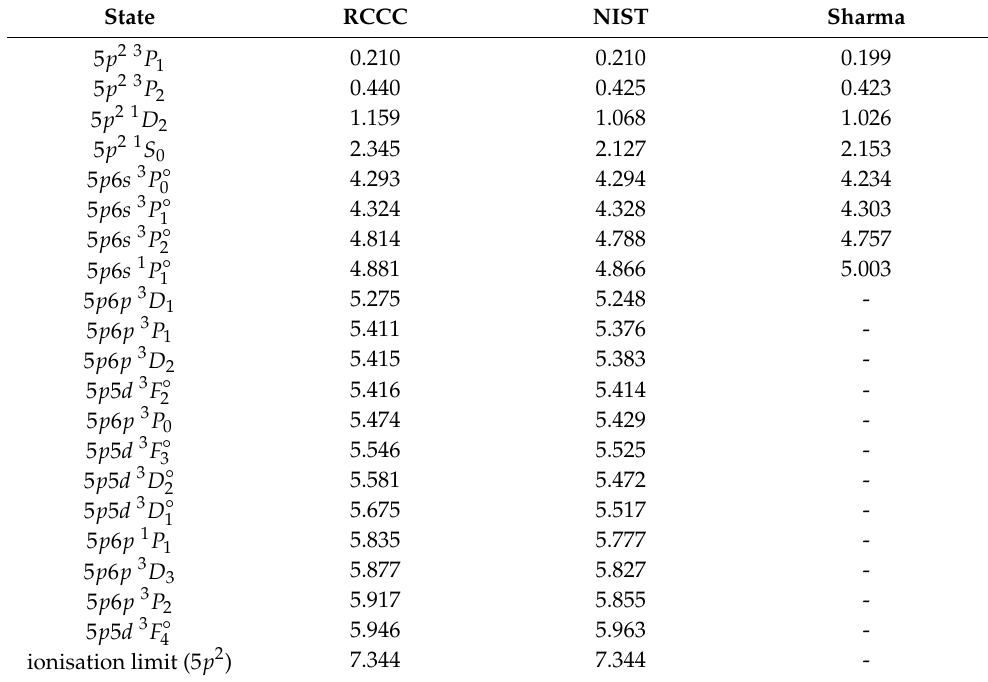
Table 1. First 20 excitation energies (eV) for the tin spectrum compared with NIST [10] and Sharma et al. [8]. State RCCC NIST Sharma